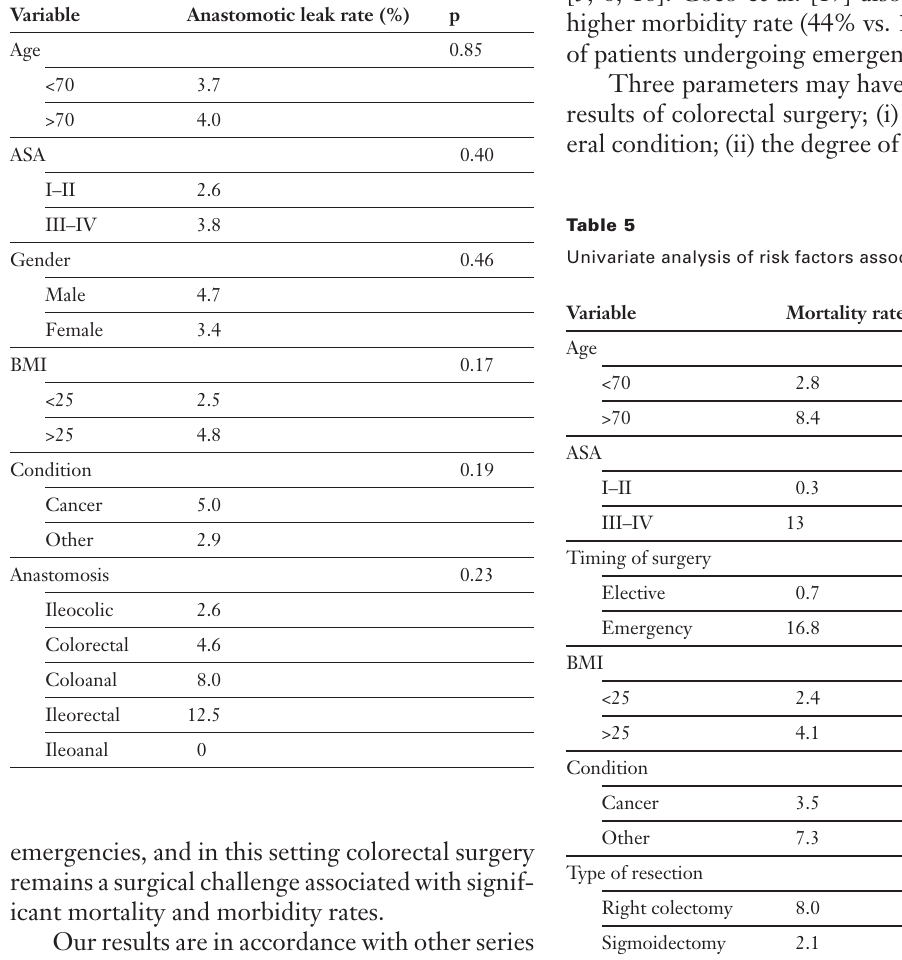
Univariate analysis of factors associated with anastomotic leak.